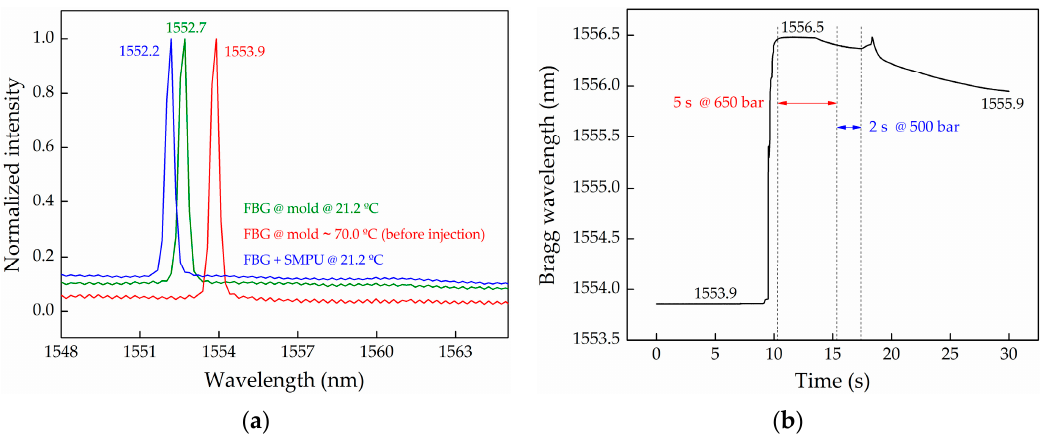
Figure 5. ( a ) FBG reflection optical spectra at different stages of the injection process; ( b ) Evolution of the Bragg wavelength along with the injection time of the SMPU into the mold cavity.